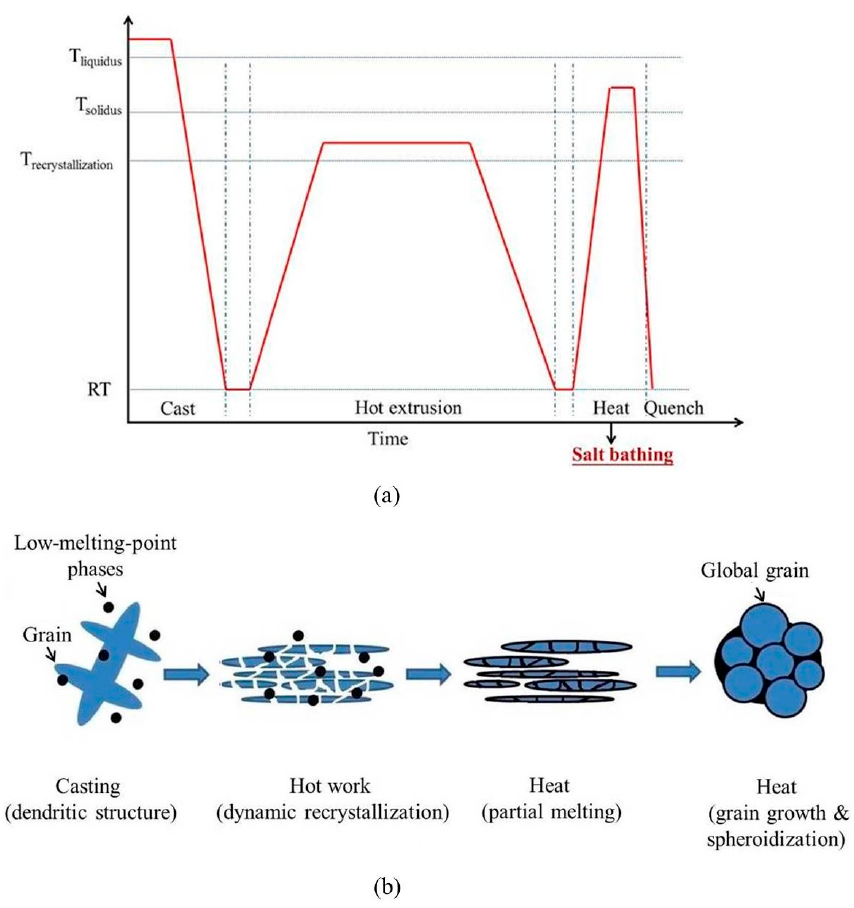
Figure 1. ( a ) Procedure of TS-SIMA process and ( b ) formation steps of globular grains in TS-SIMA process.